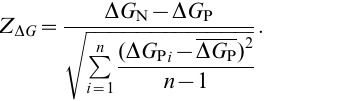
Table S2 Mean and standard error of D G for each window. Table S3 Intra-genome comparison on mean Z D G of the first window. Figure S1 Distribution of the mean Z D G as a function of window start position in different groups of species. Figure S2 The mean and standard error of Z D G of each sliding window (20 nt) in four species. Figure S3 The mean and standard error of Z D G of each sliding window (40 nt) in four species. Figure S4 Comparison of the mean Z D G obtained by different mRNA randomization procedures. Codon Shuffle algorithm permutes sequences by randomly reshuffling synonymous codons within each gene, which may change dinucleotide composition of the sequence; while DicodonShuffle algorithm shuffle codons preserving the dinucleotide composition. Figure S5 The mean Z GC of the first window as a function of the genomic GC content. Each data point represents one organism. Figure S6 Spearman correlation coefficient r between the mean Z D G and the genomic GC content for each window in bacteria, archaea, and fungi. Figure S7 The mean D G of the first window as a function of the genomic GC content. Each data point represents one organism. Figure S8 The mean D G of the tenth window vs. the mean D G of the first window. Each data point represents the entire genome of one organism. Figure S9 The difference in mean D G between the first and the tenth window as a function of the genomic GC content. Each data point represents one organism. Figure S10 Distribution of the difference in mean Z D G between genes with the highest 5% and the lowest 5% GC content for the entire data set of all 340 species. Figure S11 Comparison of the mean 5 9 Z D G between genes with the highest 5% and the lowest 5% ENC within each genome. Each data point represents one organism. Figure S12 Principal component regression of 5 9 Z D G against GC content, expression level, and ENC value. PC1, PC2, and PC3 denote the first, second, and third principal component. Found at: doi:10.1371/journal.pcbi.1000664.s015 (0.02 MB